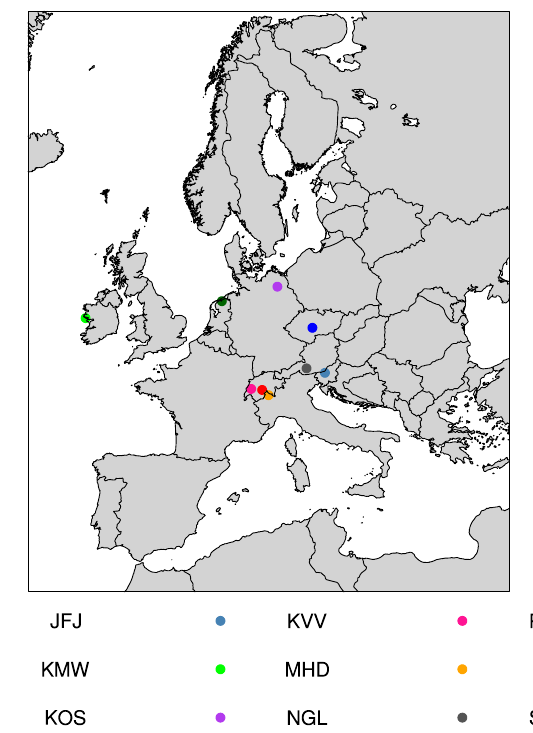
Figure 1. Map of the European model domain of the regional model, also showing the ground-based measurement stations, sum- marised in Table